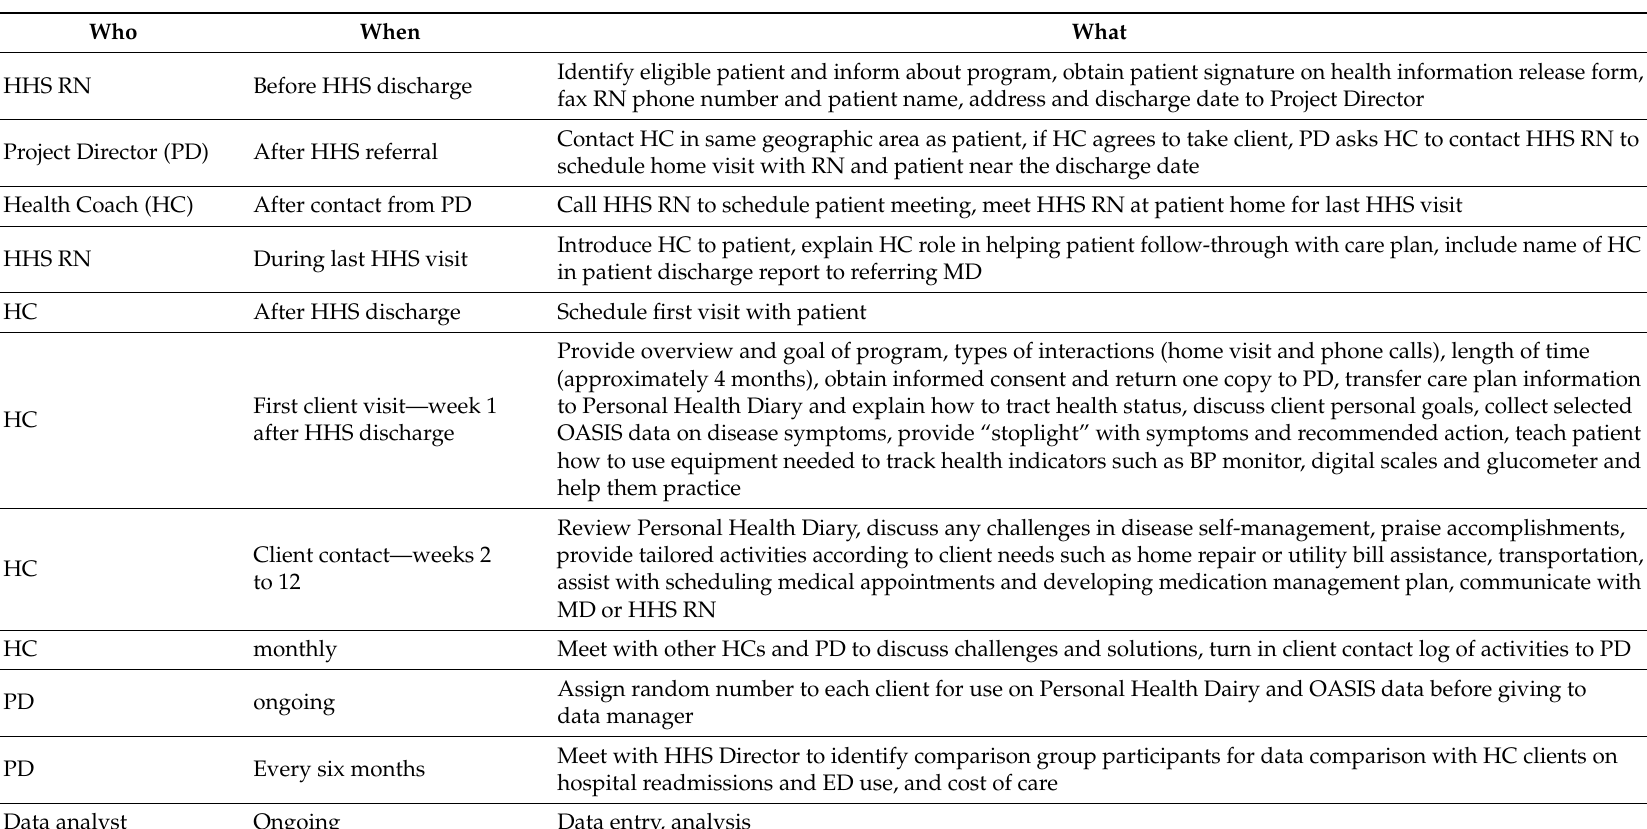
Table 1. Activities of Project